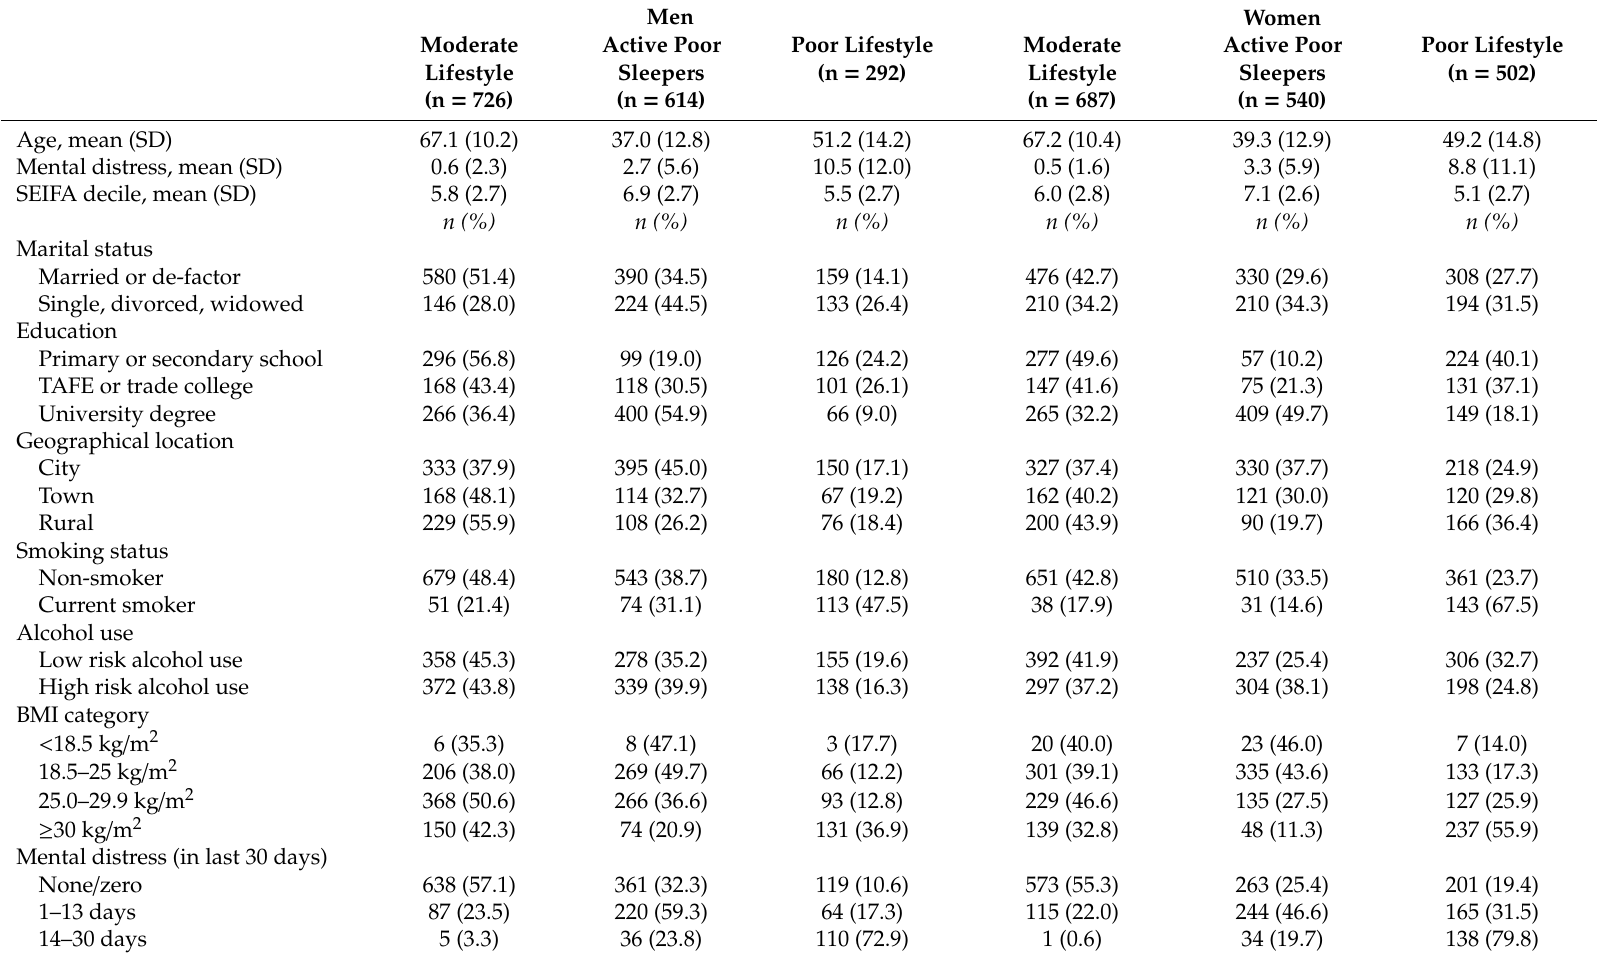
Table 4. Distribution of sociodemographic, behavioural, and health-risk indicators by latent class (n = 3374). Men